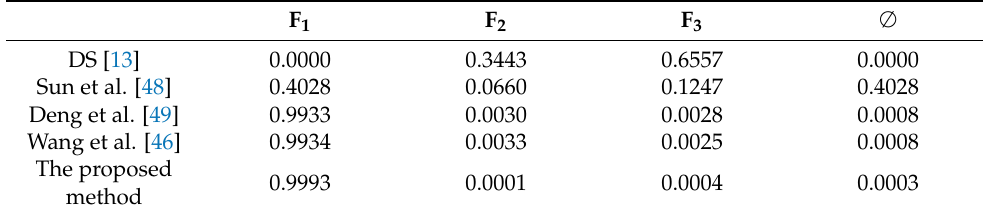
Table 3. Fusion results of